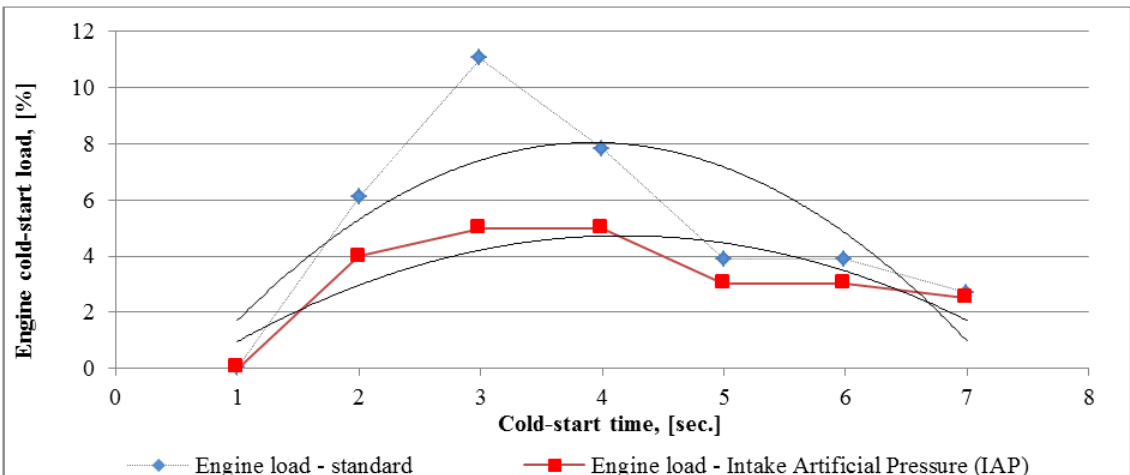
Figure 5. Engine load at